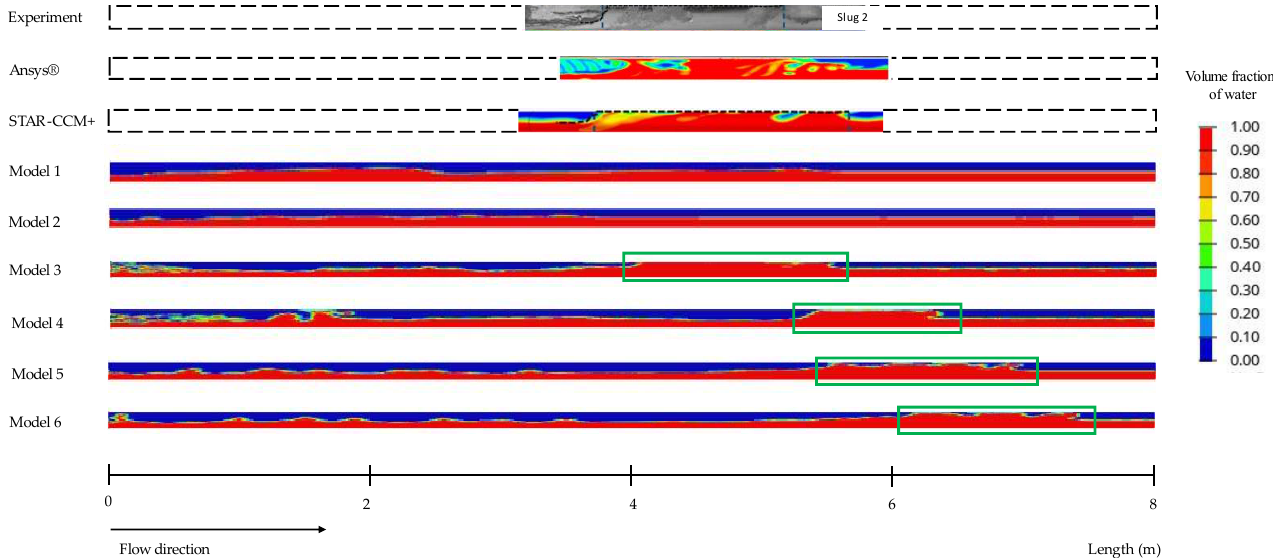
Figure 7. Flow morphology of each model implemented with various combinations of perturbations, multiphase and turbulence equations.